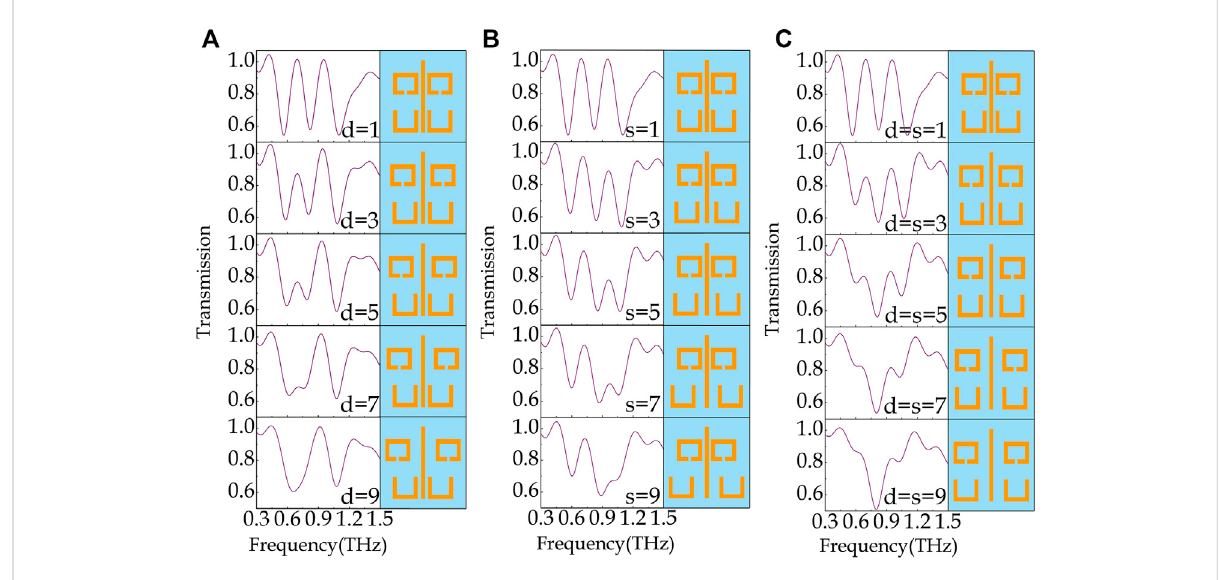
FIGURE 4 Simulated amplitude transmission spectra (left column) and schematics of the unit cells (right column) with (A) d varied from 1 to 9 μ m with an intervalof2 μ mands fi xedat1 μ m, (B) svariedfrom1to9 μ mwithanintervalof2 μ mandd fi xedat1 μ m, (C) dandssimultaneouslyvariedfrom1to 9 μ m with an interval of 2 μ